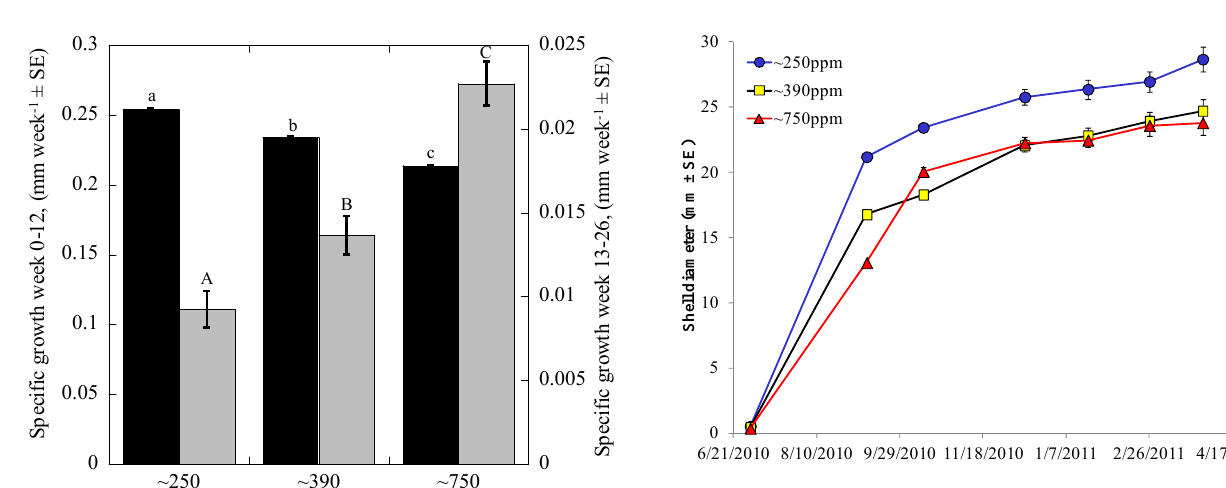
Figure 7. Shell diameter for Argopecten irradians juveniles over a 26 week period in an estuary in East Hampton, NY. Larvae ( n = 1000) were first grown under CO 2 concentrations of approximately 250, 390, and 750 µatm CO 2 (Table 6) during the larval stages before introduced into the field as juveniles. Estimates for first time point are from Chapter 3. Values are means ± 1. SE.